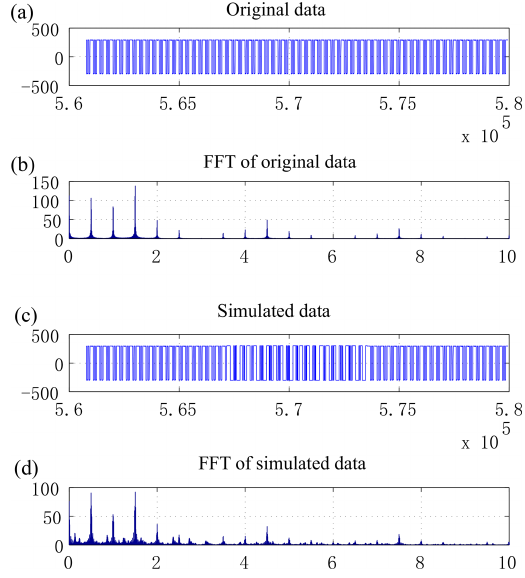
Figure 10. Original data (a, b) and simulated data of waveform repetition variation (c, d) .